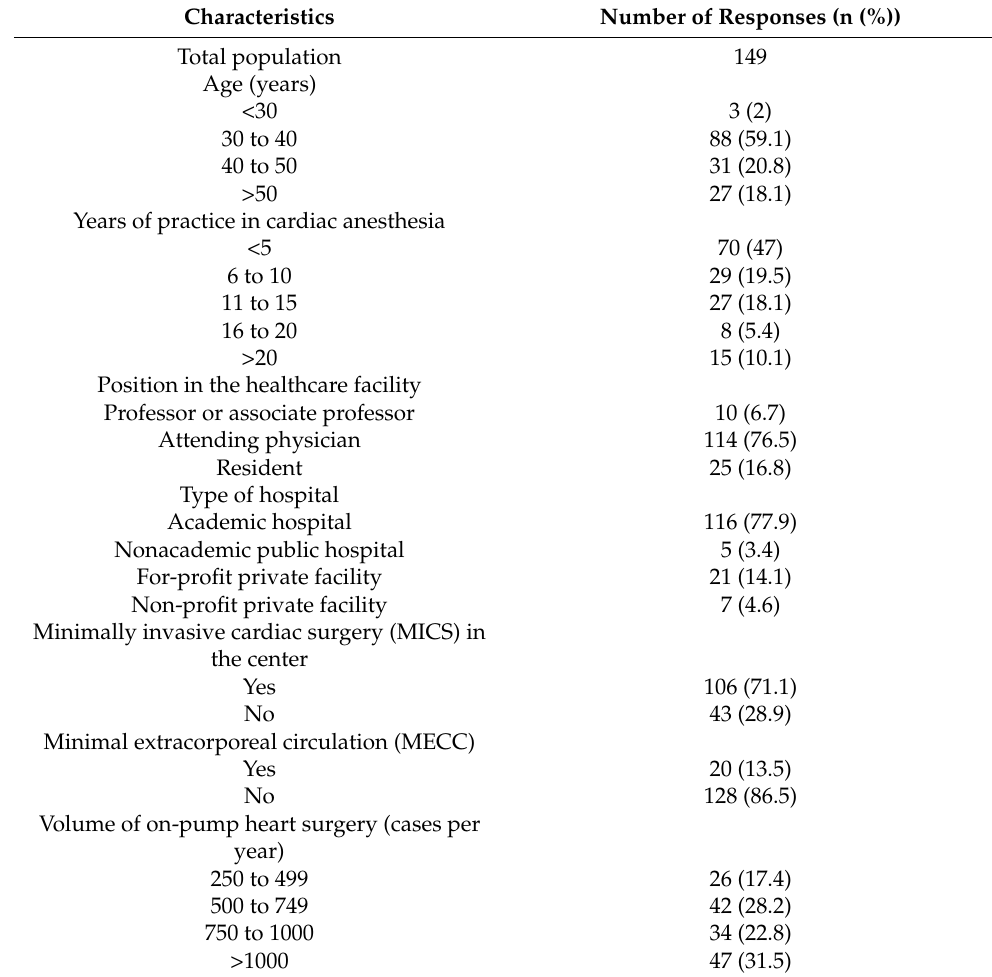
Table 1. Characteristics of the